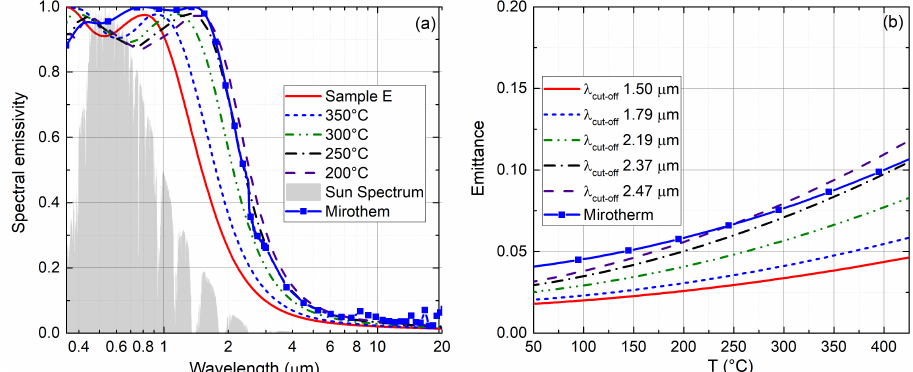
Figure 4. ( a ) Spectral emissivity of multilayer selective absorbers optimized for different temperature and consequent λ cut − of f compared with the emissivity curve of the commercial coating (blue line with square markers). ( b ) Temperature dependent emittance for different λ cut − of f calculated using Equation